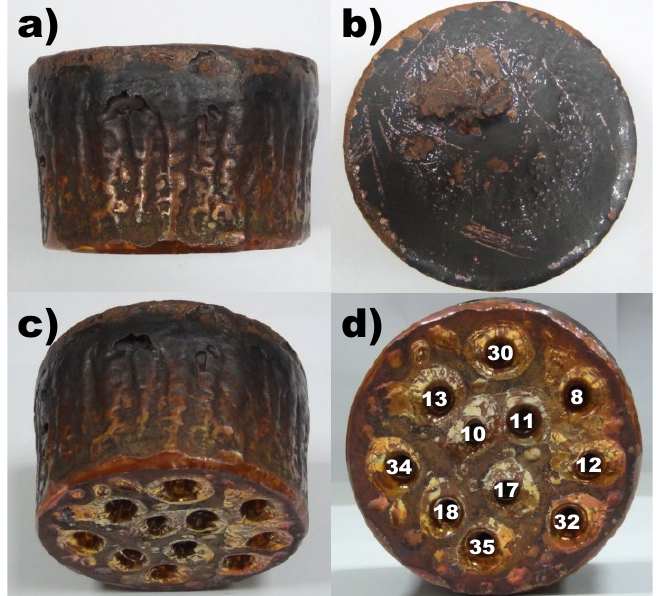
Figure 2. Original copper ingot with channel structures formed after copper nanoparticle synthesis experiments using electron beam evaporation. ( a ) Side view; ( b ) top view; ( c ) side-bottom view; and ( d ) bottom view with the channel structure depths labeled in